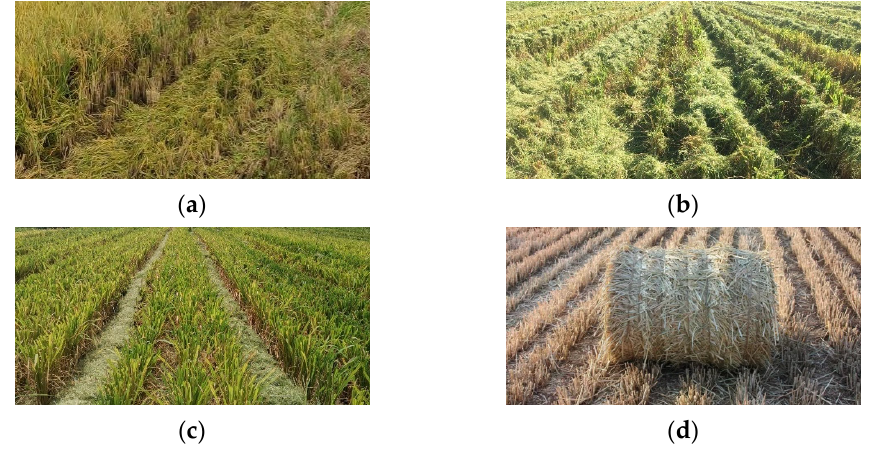
Figure 12. Ways of straw disposal and effect. ( a ) Straw directly discharged and placed disorderly; ( b ) straw smashed and scattered evenly; ( c ) straw smashed and scattered directionally; ( d ) straw baling.